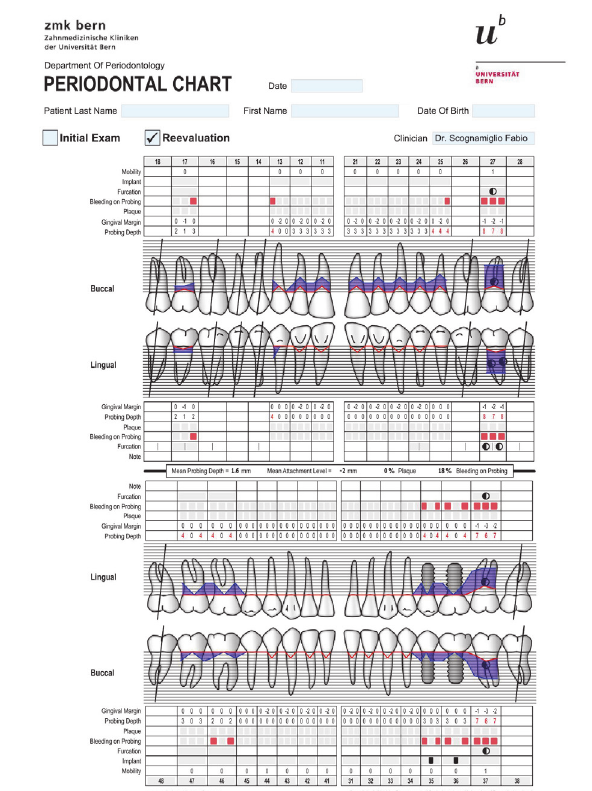
Figure 10: One month after nonsurgical periodontal therapy.